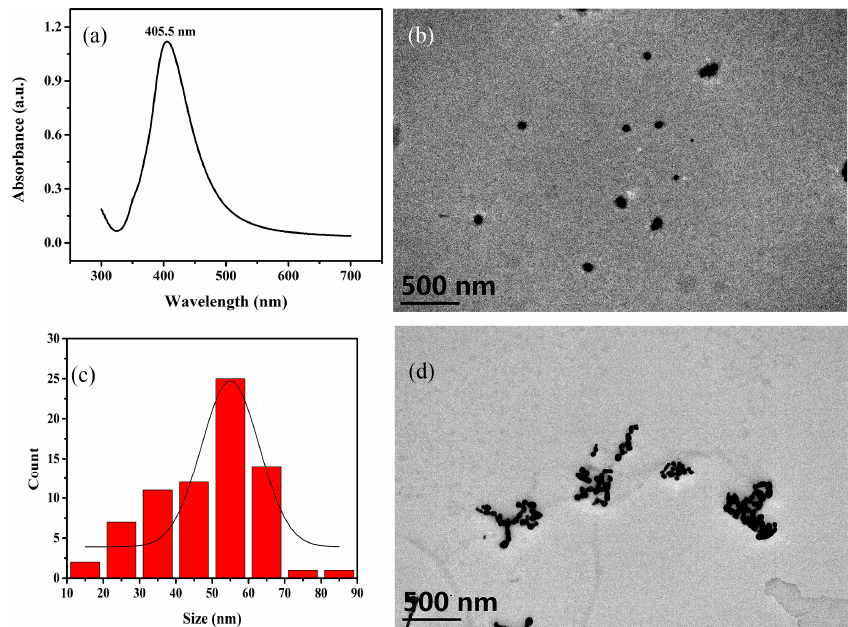
Figure 1. The characteristics of Ag NPs. ( a ) UV-Vis spectrum of Ag nanoparticles (NPs) as prepared. ( b ) Transmission electron microscope (TEM) image of Ag NPs as prepared. ( c ) Particle size distribution of Ag NPs ( d ) TEM image of Ag NPs after the addition of trichloroacetic acid (TCA).